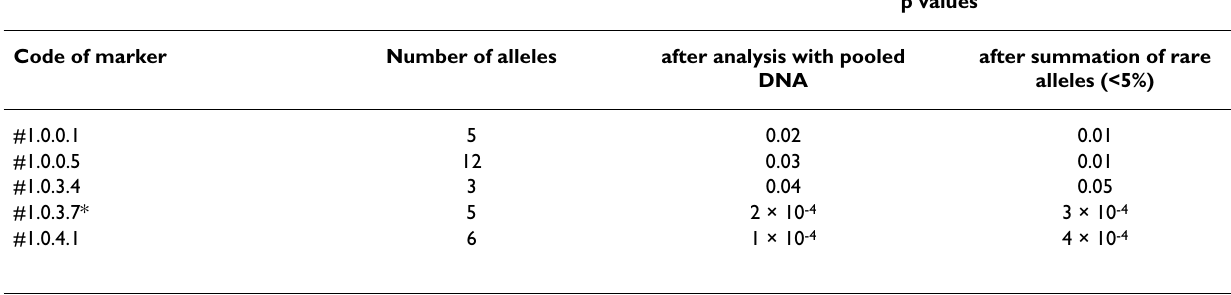
Table 2: P values for microsatellite markers after the initial step and individual genotyping. Code of marker Number of alleles after analysis with pooled